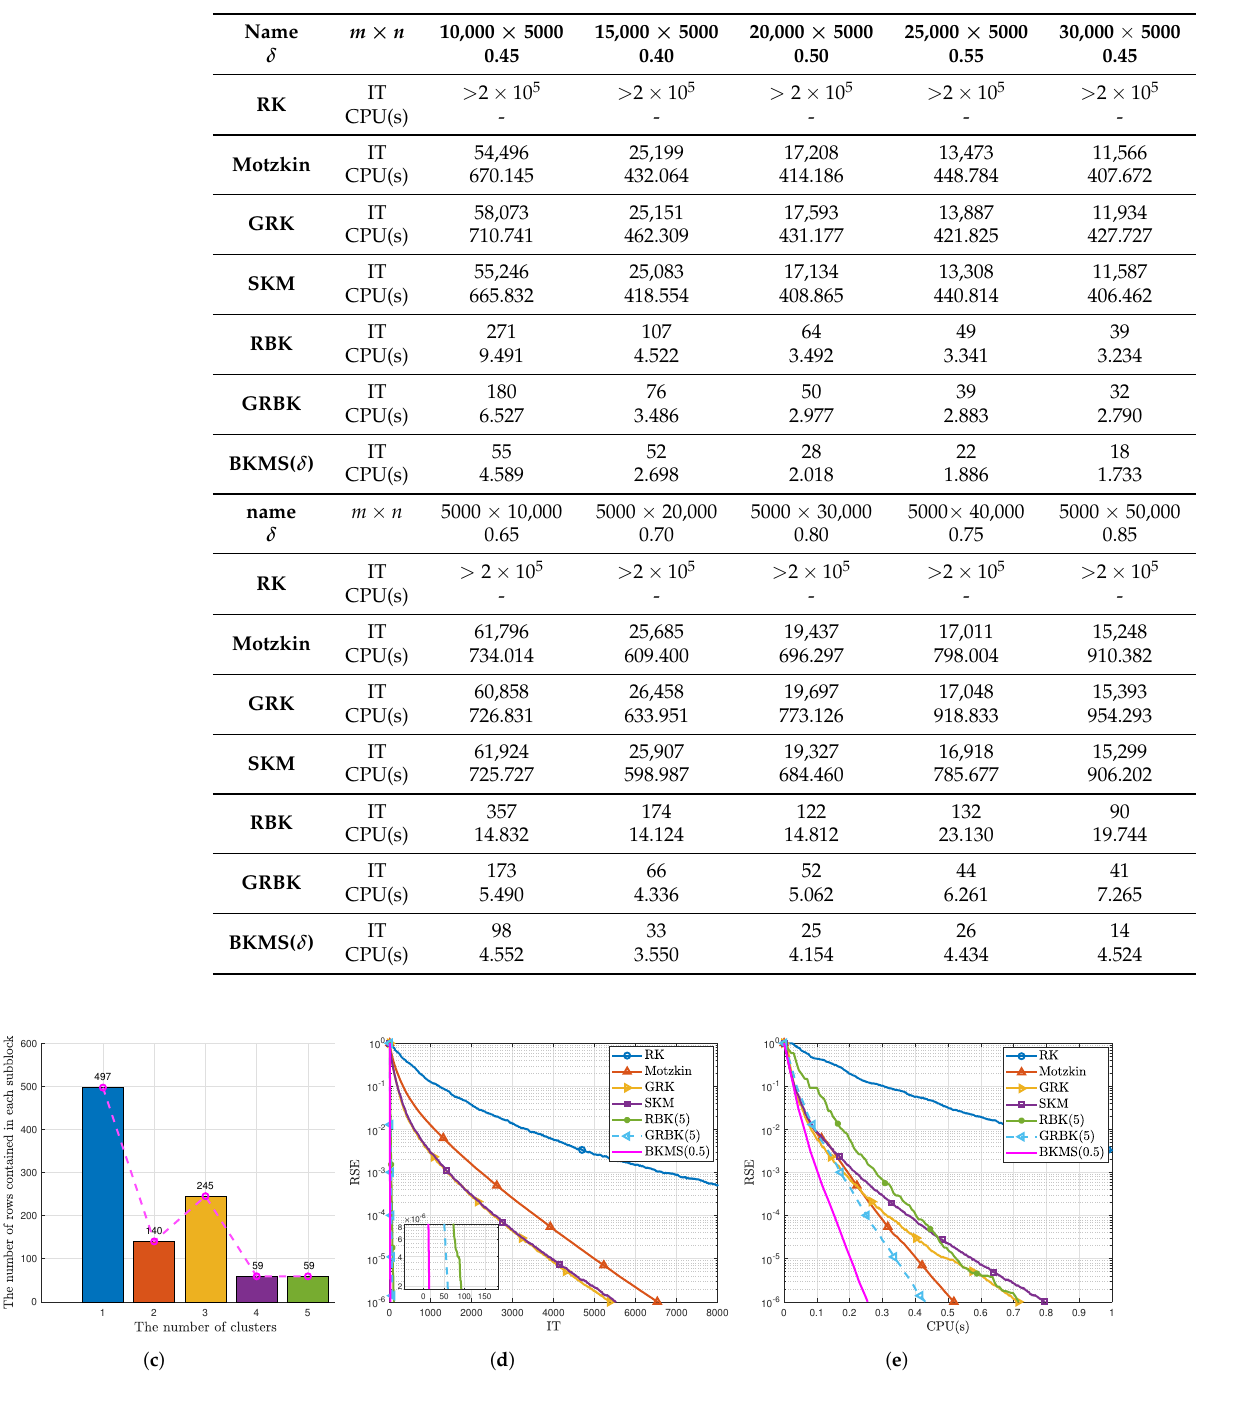
Figure 2. ( a ) The number of rows contained in each partition in BKMS with δ = 0.5. The RSE versus IT ( b ) and RSE versus CPU ( c ) of BKMS compared with other methods for a consistent linear system with A ∈ R 1000 × 500